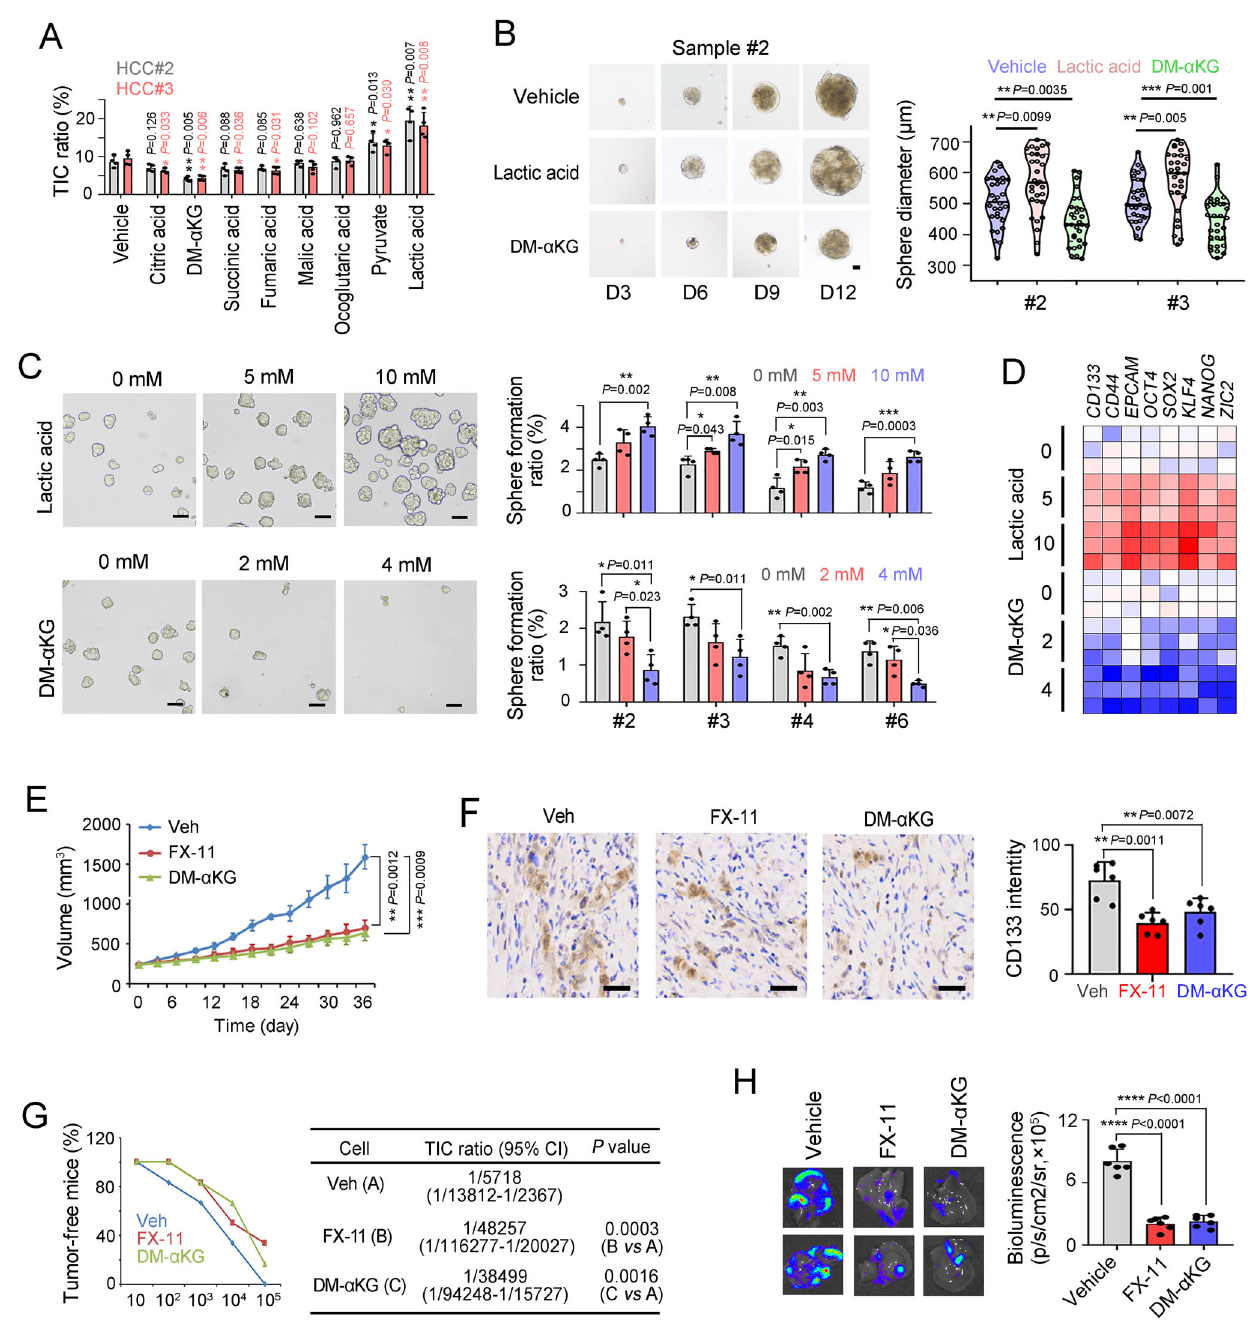
Fig. 4 | Lactate and α -KG are involved in liver TIC self-renewal. A CD133 + TIC ratios after 2days ’ treatment with the indicated metabolites were detected via FACS. DM- α KG, cell permeable α -KG. n =4 independent experiments. B Typical images and sphere diameters in lactate and DM- α KG treated sample #2 cells. n =30 spheres from three independent experiments were measured. D3, day 3. Scale bars, 100 μ m. C Sphere formation of sample #2 cells supplemented with indicatedlevelsoflactateandDM- α KG. n =4independentexperiments.Scalebars, 500 μ m. D Quantitative real-time PCR detection for the indicated gene expression in lactate and DM- α KG treated primary sample #2 cells. n =3 independent experi- ments. E Xenografttumorswere established inBALB/c nude miceand treatedwith FX-11 or DM- α KG after tumors reached about 250mm 3 , and tumor volume was detectedevery3days. n =66-week-oldmaleBALB/cnudemicepergroup. F CD133